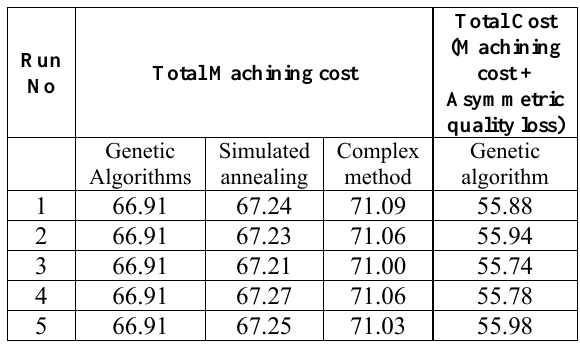
Figure 9 Comparison total cost with number of trial run for Genetic